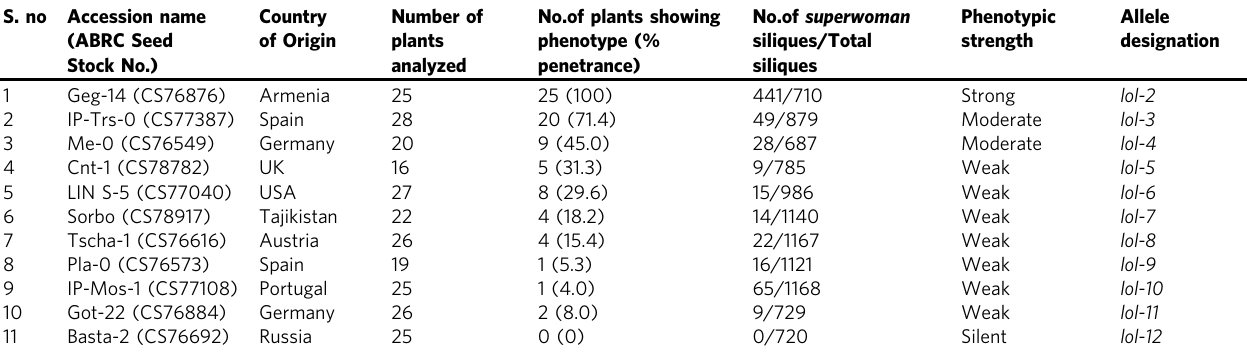
Table 1 Phenotypic analysis of natural SUP epialleles ( lol) from diploid natural A. thaliana accessions. S. no Accession name (ABRC Seed Stock